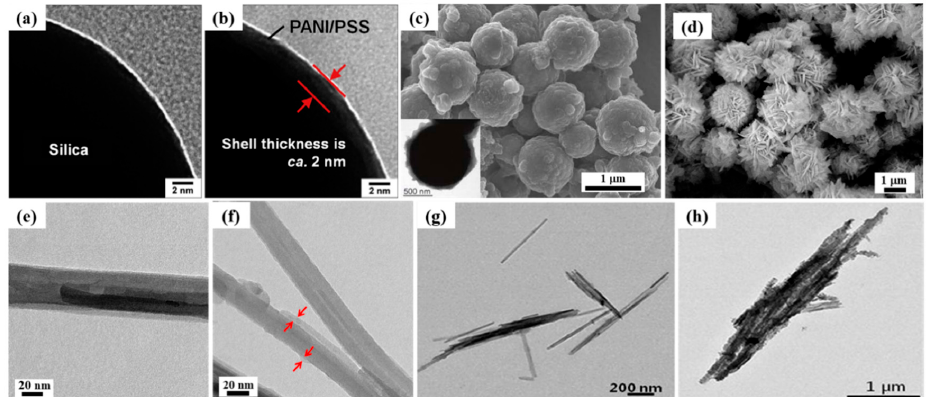
Figure 2. Morphologies of PANI coated inorganic nanoparticles: ( a , b ) SiO 2 and PANI/PSS-coated SiO 2 (Range between red arrows shows the thickness of PANI/PSS) (Lee et al. [70], © Elsevier, 2013); ( c ) Fe 3 O 4 /PANI (Sim et al. [72], © BME-PT, 2015); ( d ) flower-like Fe 2 O 3 /PANI (Tian et al. [73], © Elsevier, 2016); ( e , f ) SPL and PANI/SPL (Jang et al. [74], © Elsevier, 2015); ( g , h ) Pal and Pal/PANI (The red arrows point PANI) (Chae et al. [76], © Elsevier, 2007).